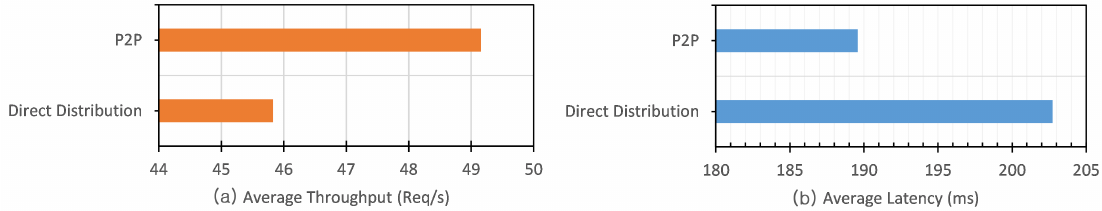
Figure 13. Comparison of average throughput ( a ) and average latency ( b ) in the Download Update step between direct firmware update and peer-to-peer firmware